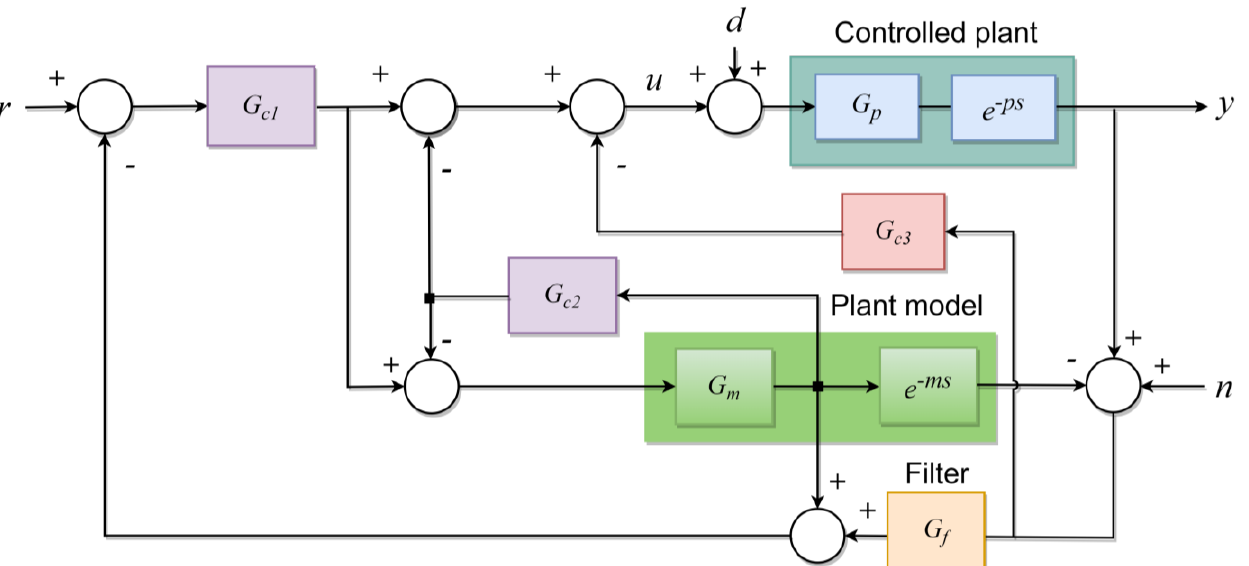
Figure 1. Modified Smith predictor structure proposed by Ajmeri and Ali [18] (reproduced with permission from Ajmeri and Ali). Analytical design of a modified Smith predictor for unstable second-order processes with time delay, published by International Journal of Systems Science, 2017.